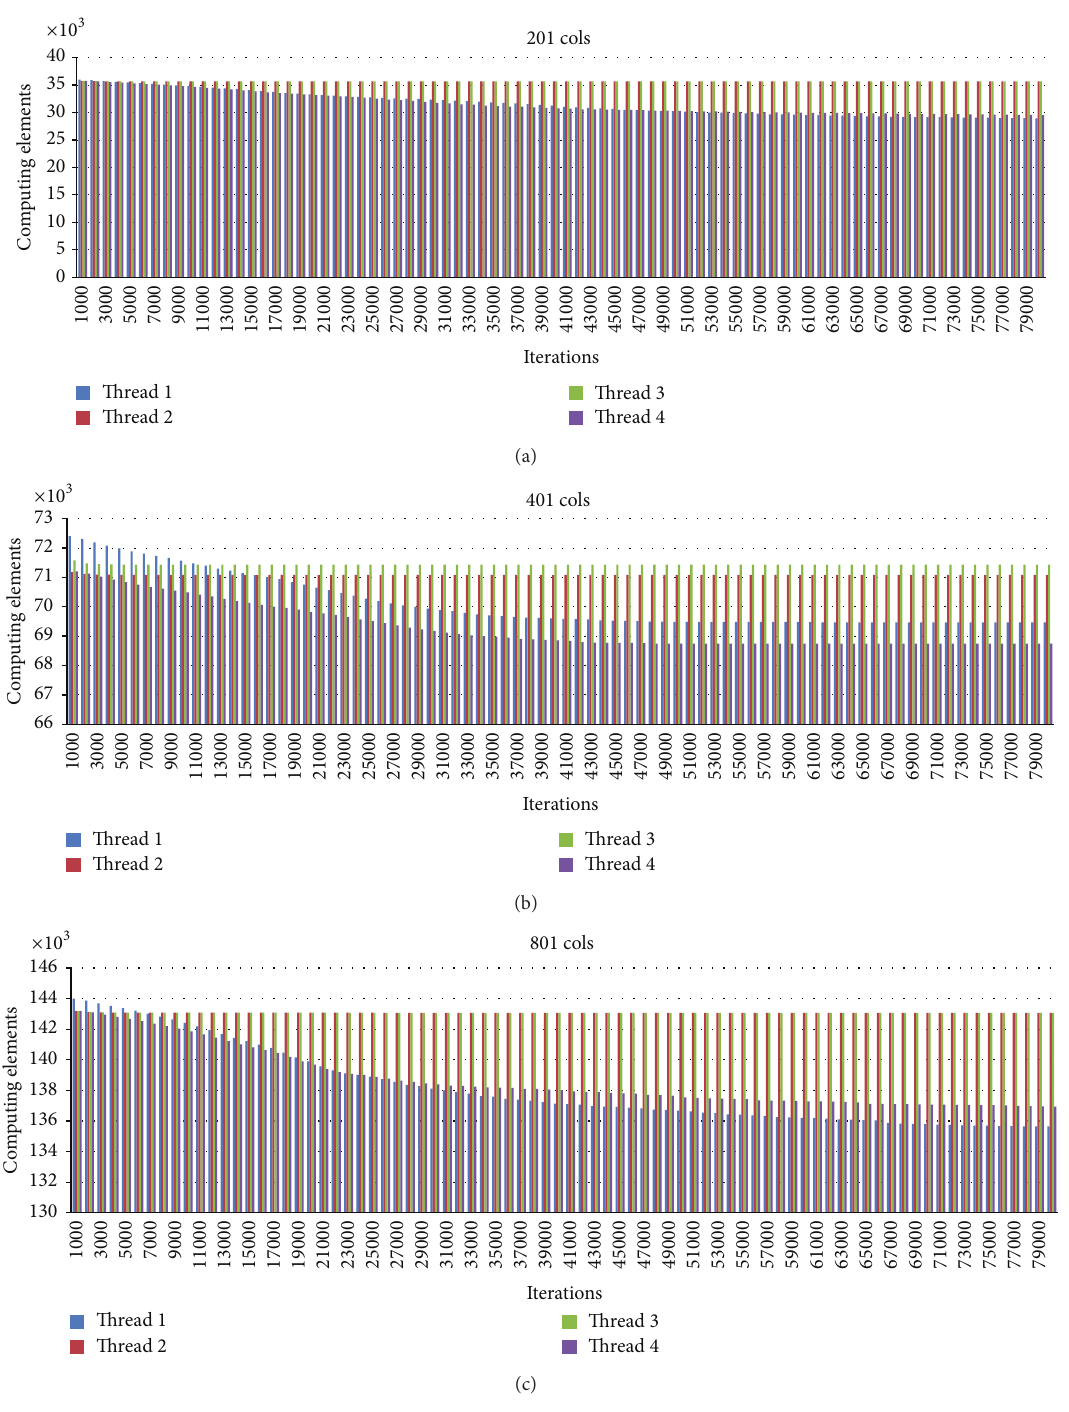
Figure 13: The workload of each thread for 4 threads using static schedule 𝑐ℎ𝑢𝑛𝑘 𝑠𝑖𝑧𝑒 = 𝑁/𝑇 .